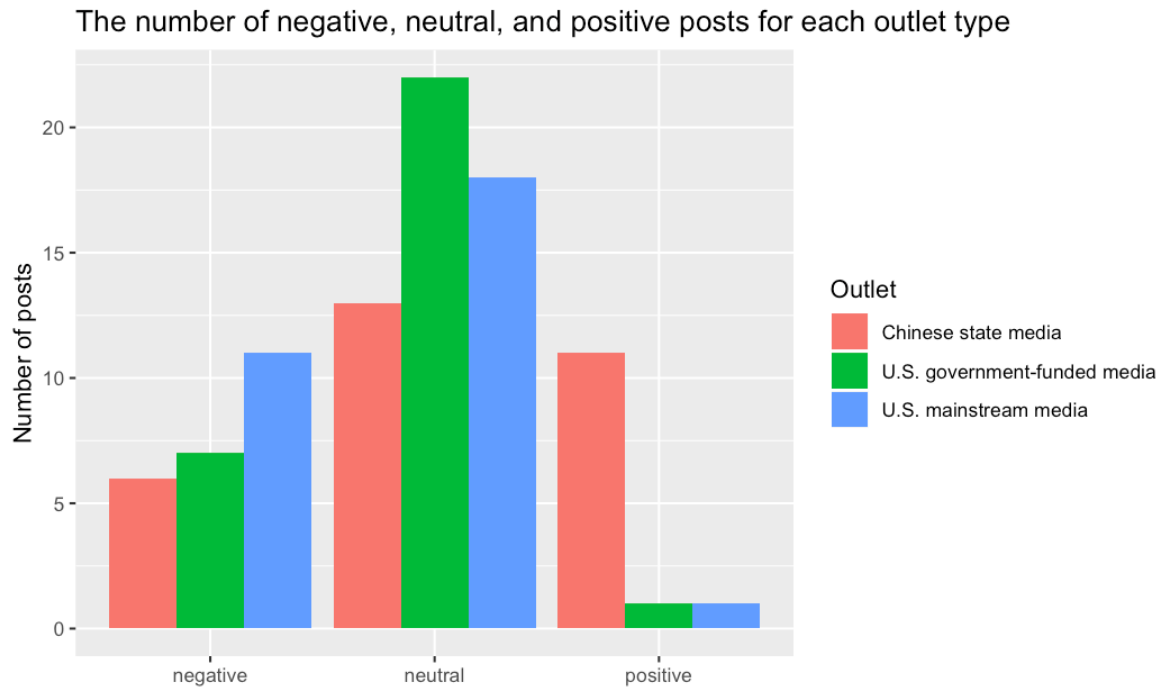
Figure 1 : The number of negative, neutral, and positive posts for each of the three outlets across 90 randomly selected posts (30 for each outlet). Chinese state media include a significantly higher share of positive